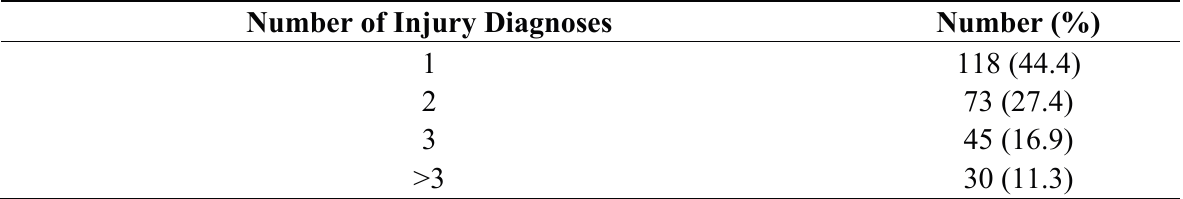
Table 1. Number of injury diagnoses in admitted patients with earthquake-related